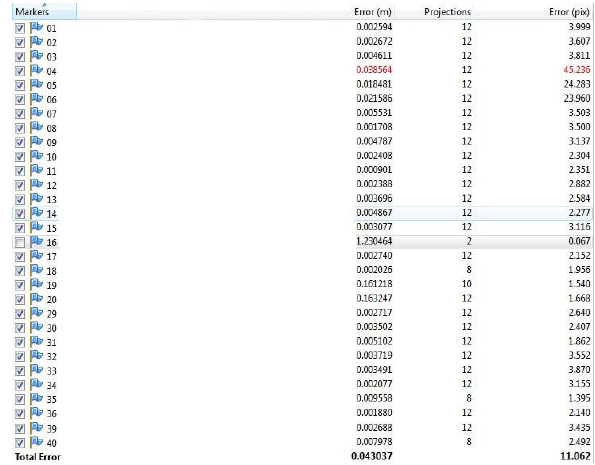
Table 10. Results of the bundle adjustment process for GoPro camera A maximum error of 38.564 mm and an average total error of